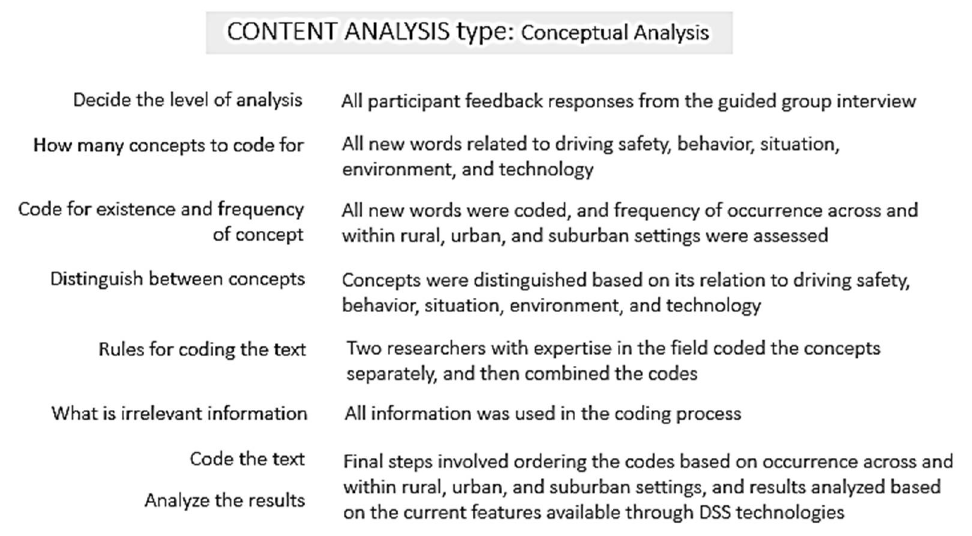
Figure 1. Steps for conducting the content analysis using the participant feedback responses.